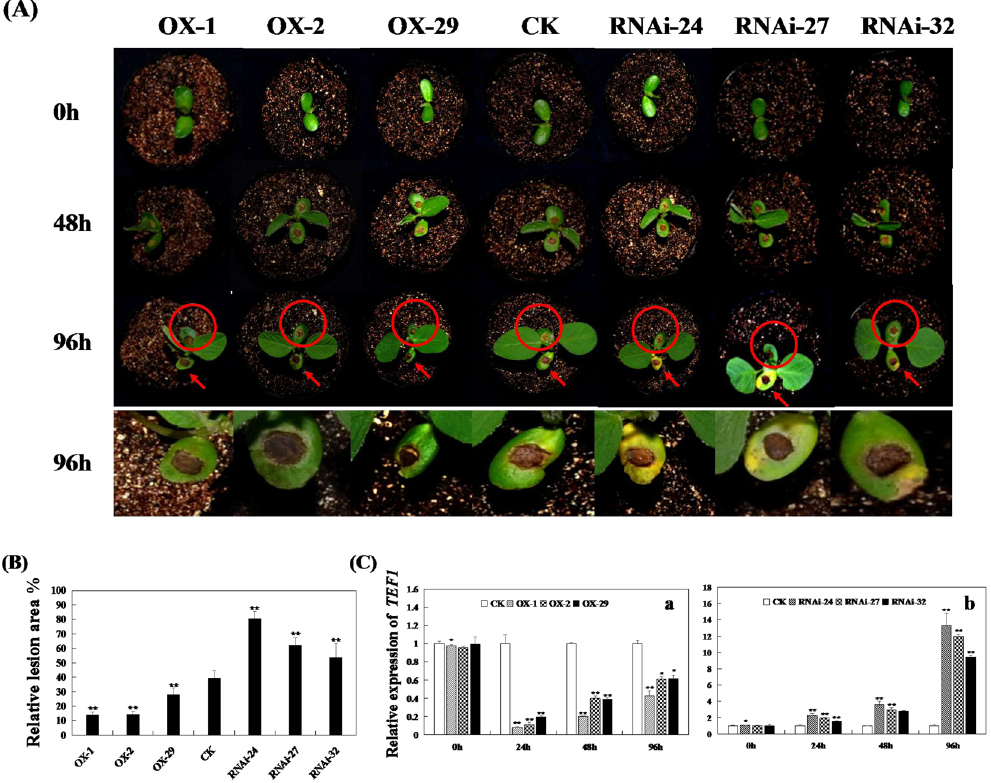
Figure 5. GmPAL2.1 enhances resistance to P . sojae in transgenic soybean cotyledons. ( A ) Disease symptoms on the living cotyledons of transgenic lines and non-transgenic lines treated with P . sojae inoculum at 48 h and 96 h. ( B ) The relative lesion area of transgenic soybean cotyledon infection with P . sojae after 96 h. The average lesion area of each independent transgenic line (n = 3) was calculated, and their relative lesion areas are shown in columns after a comparison with the average lesion area on non-transgenic soybean. ( C ) Quantitative real- time PCR analysis of the P . sojae relative biomass in three GmPAL2.1-overexpressing soybean plants (a) and three GmPAL2.1-RNAi soybean plants (b) based on the transcript level of the P . sojae TEF1 gene. The experiment was performed on three biological replicates with their respective three technical replicates and statistically analyzed using Student’s t-test ( * P < 0.05, ** P < 0.01). Bars indicate the standard error of the mean.